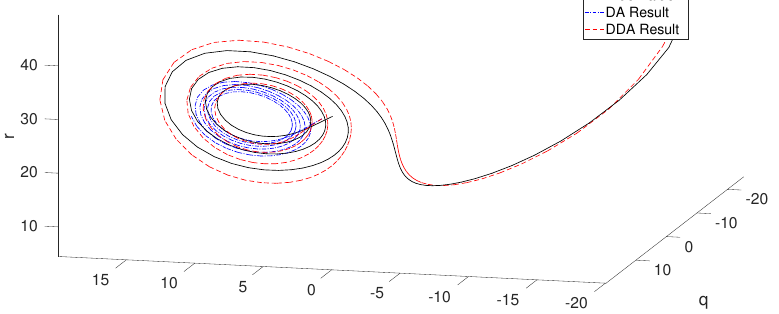
Figure 12. Forecasts of the DA and DDA trajectories. It is the three-dimensional (3D)-plot of Figure 11 for timestep ∈ ( 1000,1176 )